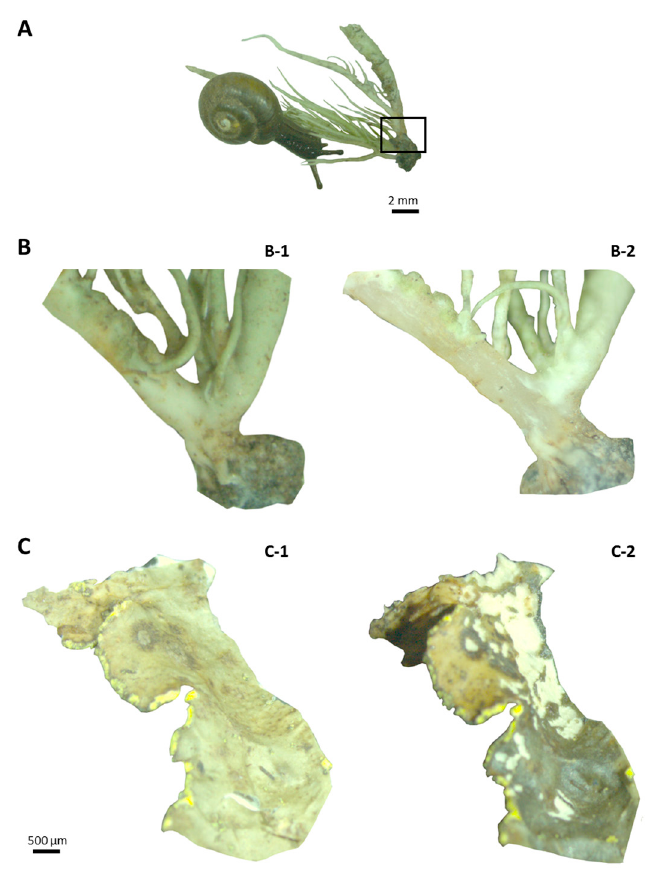
Figure 8. ( A ) N. hookeri consuming U. taylorii thallus. U. taylorii ( B ) and P. crocata ( C ) thalli before and after snail consumption. The medulla remained untouched for both lichens. The specimens were dry before consumption ( B-1 and C-1 ) and wet after snail feeding ( B-2 and C-2 ). The inset ( A ) corresponds to the magnification used in B